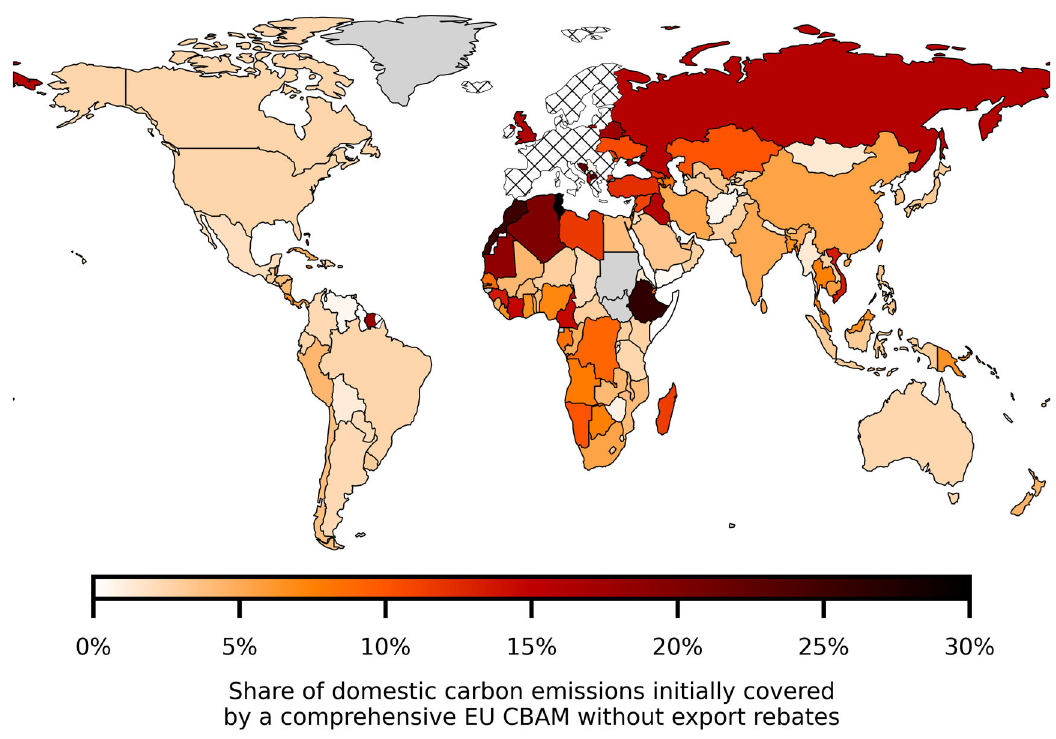
Fig. 3 Relative upstream pressure induced by a comprehensive EU CBAM without export rebates. The relative upstream pressure is de fi ned as the share of CO 2 emissions caused to supply the fi nal demand in the EU, as a percentage of domestic carbon emissions. Grey indicates lack of data, hatchings indicates member countries of the EU ETS. The relative upstream pressure does not consider possible trade